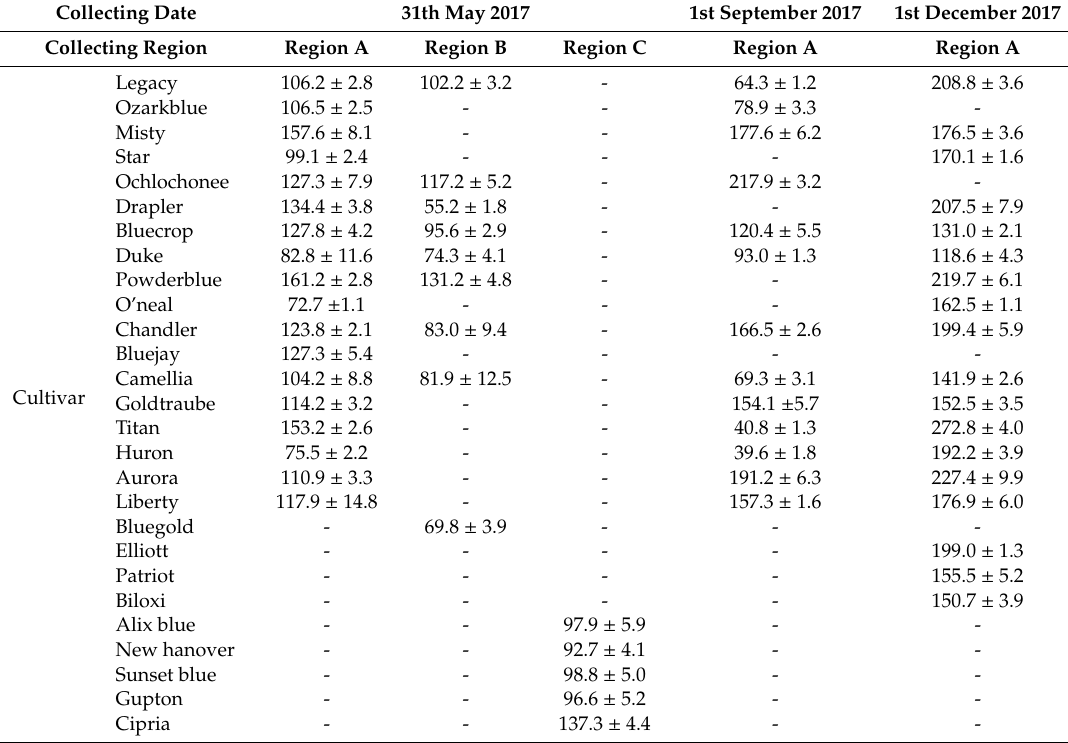
Table 1. Total phenolic content (TPC), expressed in mg gallic acid / g dry leaf, obtained for all the cultivar leaves extracts harvested in the three geographic regions and three seasons across the vegetative